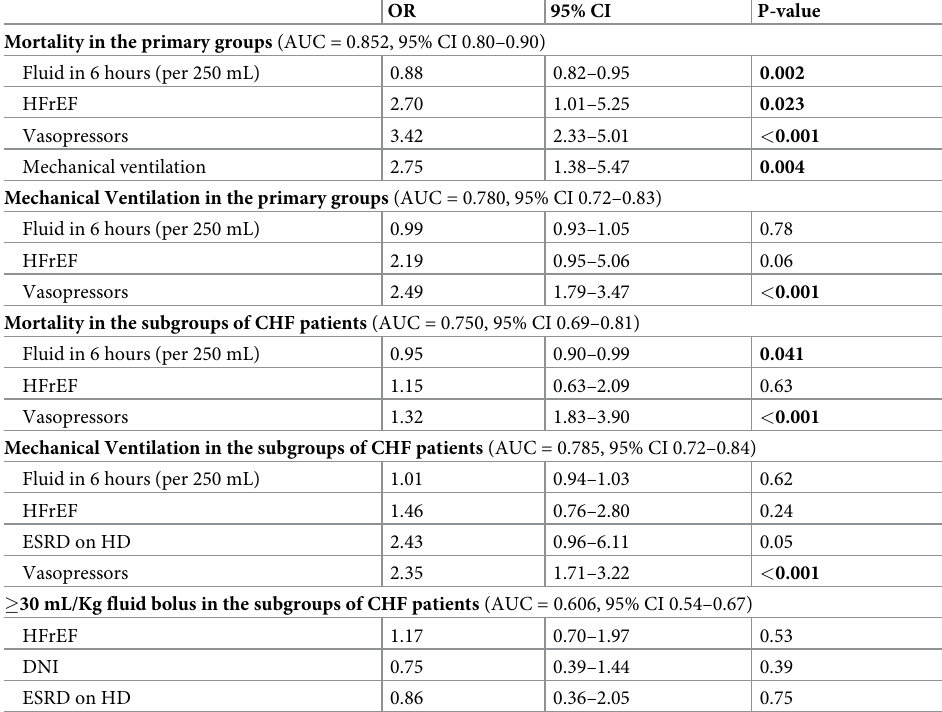
Table 3. Multivariable logistic regression model predicting the outcomes in the primary groups and the CHF subgroups. OR 95% CI P-value